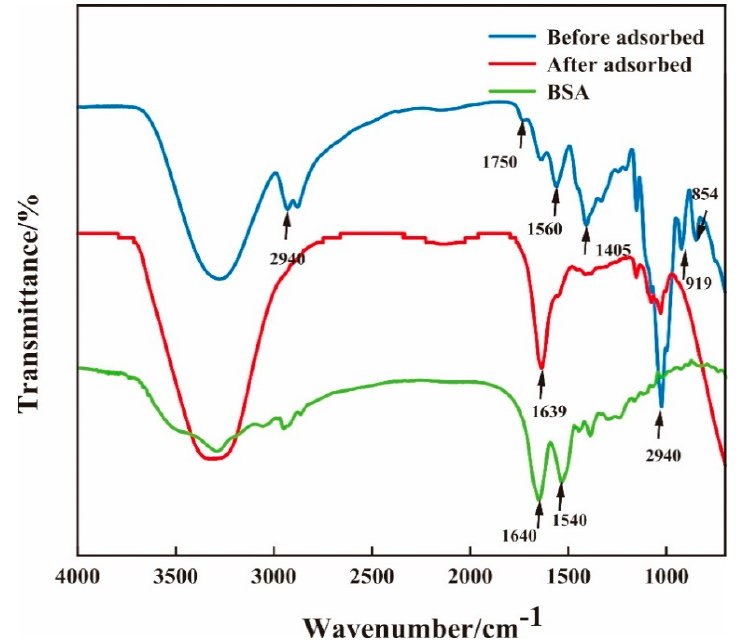
Figure 4. Changes of FT-IR before and after adsorption of BSA on the